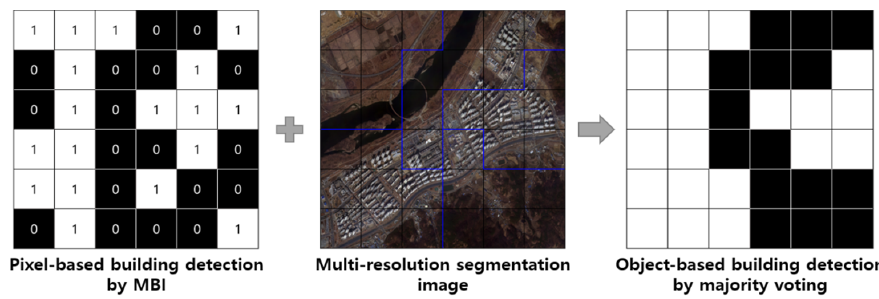
Figure 2. Basic concept of majority voting.